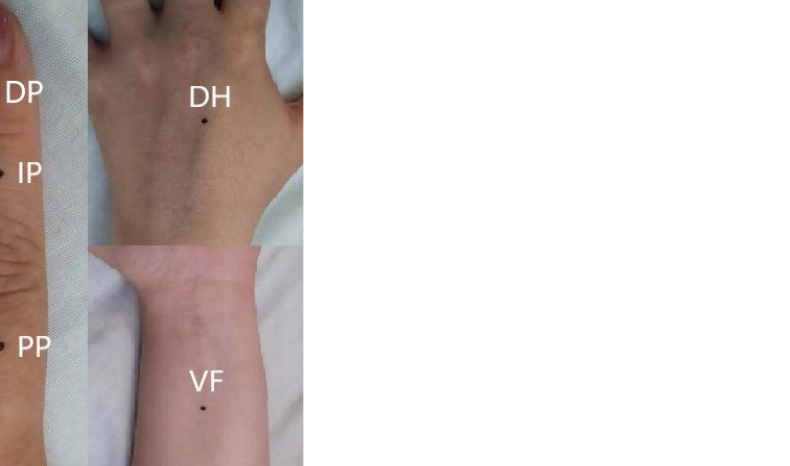
Table 1. Baseline characteristics of SSc cohort and